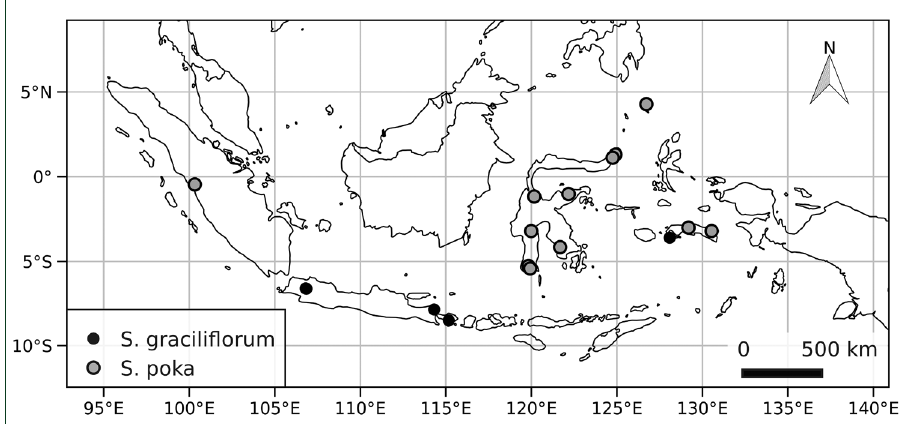
Figure 2. Distribution of Solanum graciliflorum and Solanum poka in the Malay Archipelago. Geographical information for these collections can be found in the data supplement to this article (Suppl. material